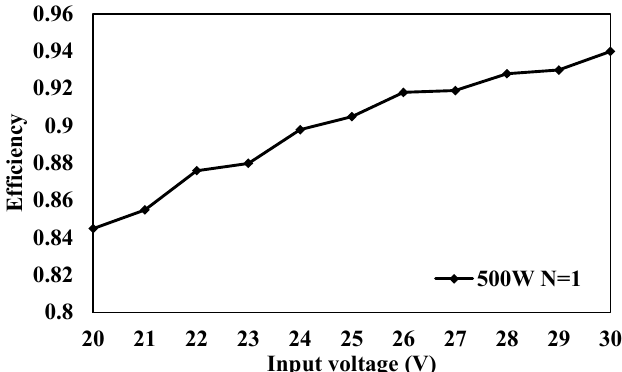
Figure 12. Measured conversion efficiency under different input voltages at 500 W. The relation between efficiency and output power when duty cycle is 0.75 and input voltages are 20 V, 25 V and 30 V is shown in Figure 13. When the output power is fixed, efficiency is positively related with input voltage. When the input voltage is fixed, efficiency is negatively correlated with output power.